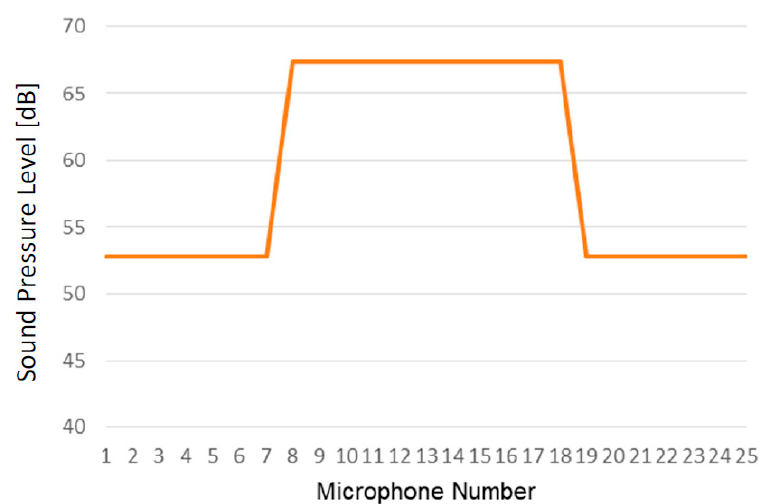
Figure 6. Curve trend of the theoretical model at 500 Hz.